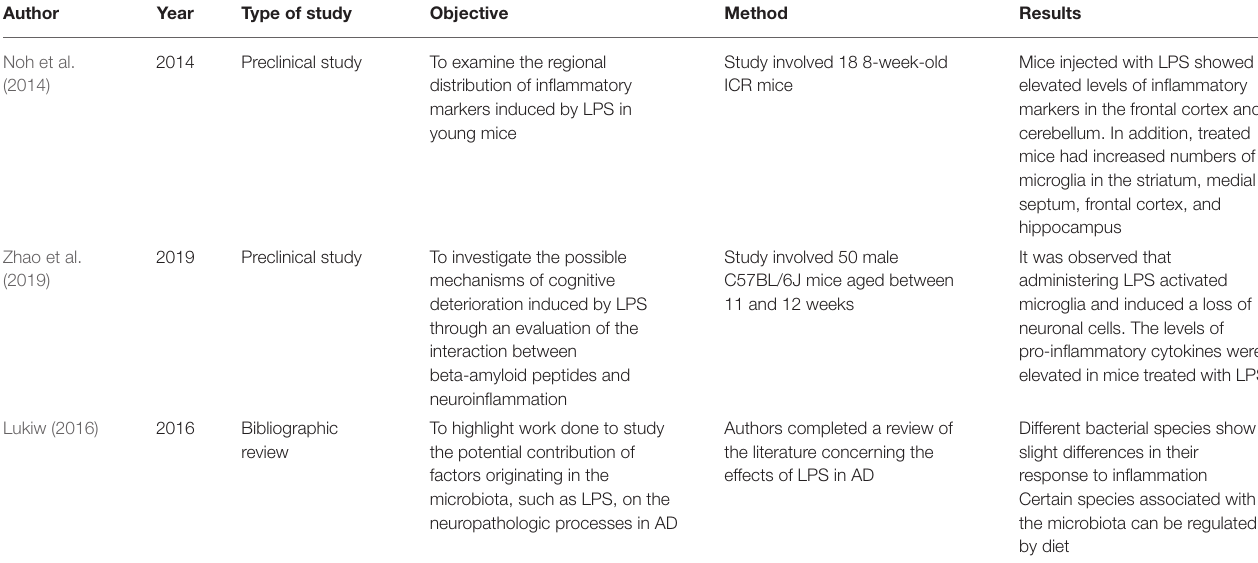
TABLE 3 | Microbiota and the immune system.